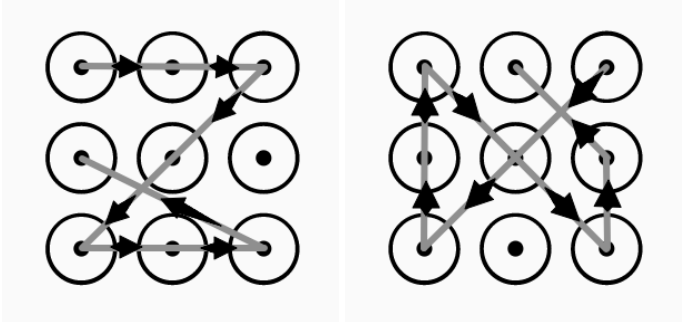
Figure 6. Two patterns used in the experiment. Left: 1 → 2 → 3 → 5 → 7 → 8 → 9 → 4; Right: 3 → 5 → 7 → 4 → 1 → 9 → 6 →